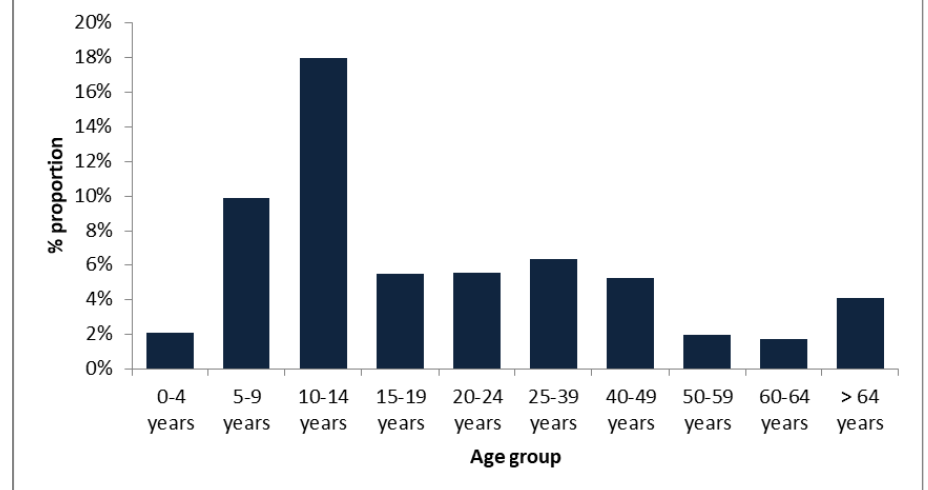
Figure 1. Distribution of influenza B viruses (IBV) cases in Uruguay according to age groups, 2012–2019.The proportion of positive samples for IBV for the different age groups are